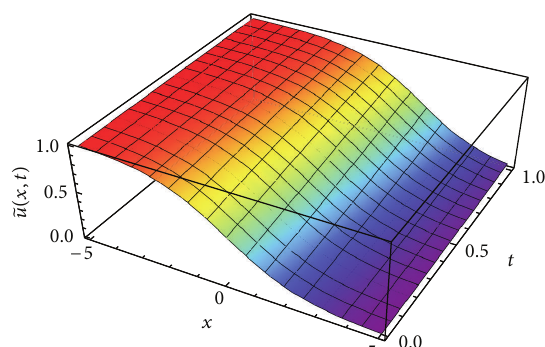
Figure 7: The approximate solution of problem (44) with 𝜃 = 𝜗 = 0 , = 0.01 , 𝜏 = 0.5 , and 𝑁 = 40 . 𝜆 1